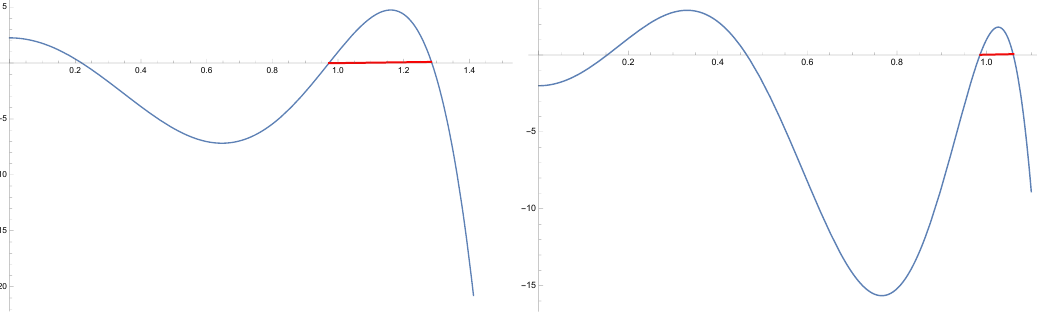
Figure 5: A comparative plot of changing regions of positivity in ξ with spin for f ( 3 )